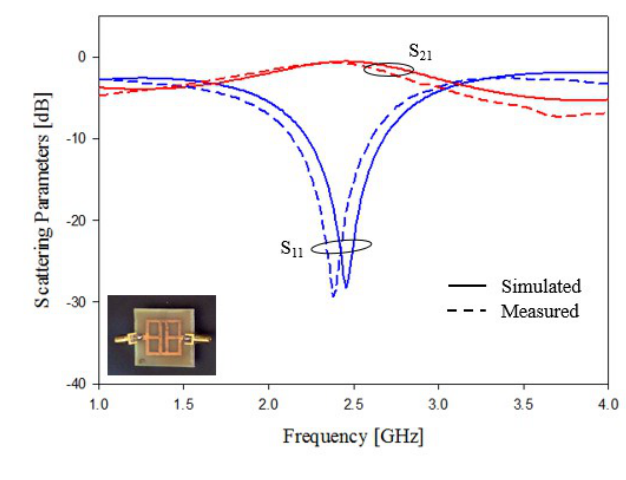
Figure 18. Experimental assessment, T-shaped stubs of length equal to L perpendicular to the feeding line, prototype of Figure 7a. Comparisons between numerical and measured scattering parameters.